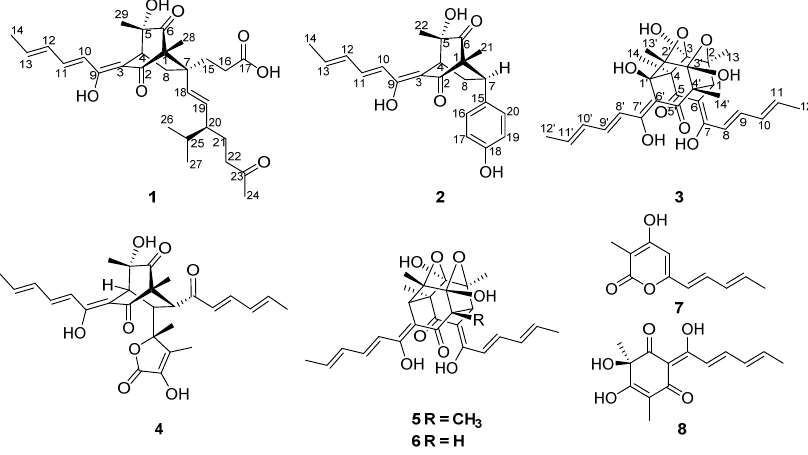
Figure 1. Structures of compounds 1 – 8 .